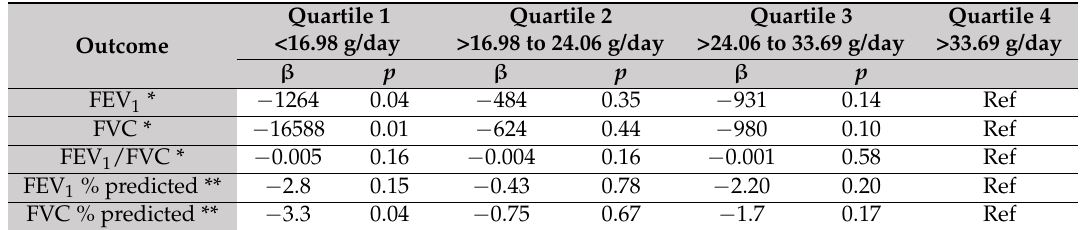
Table 2. Results of multivariate regression models for saturated fat and lung function in adults with airflow obstruction ( n = 1424).